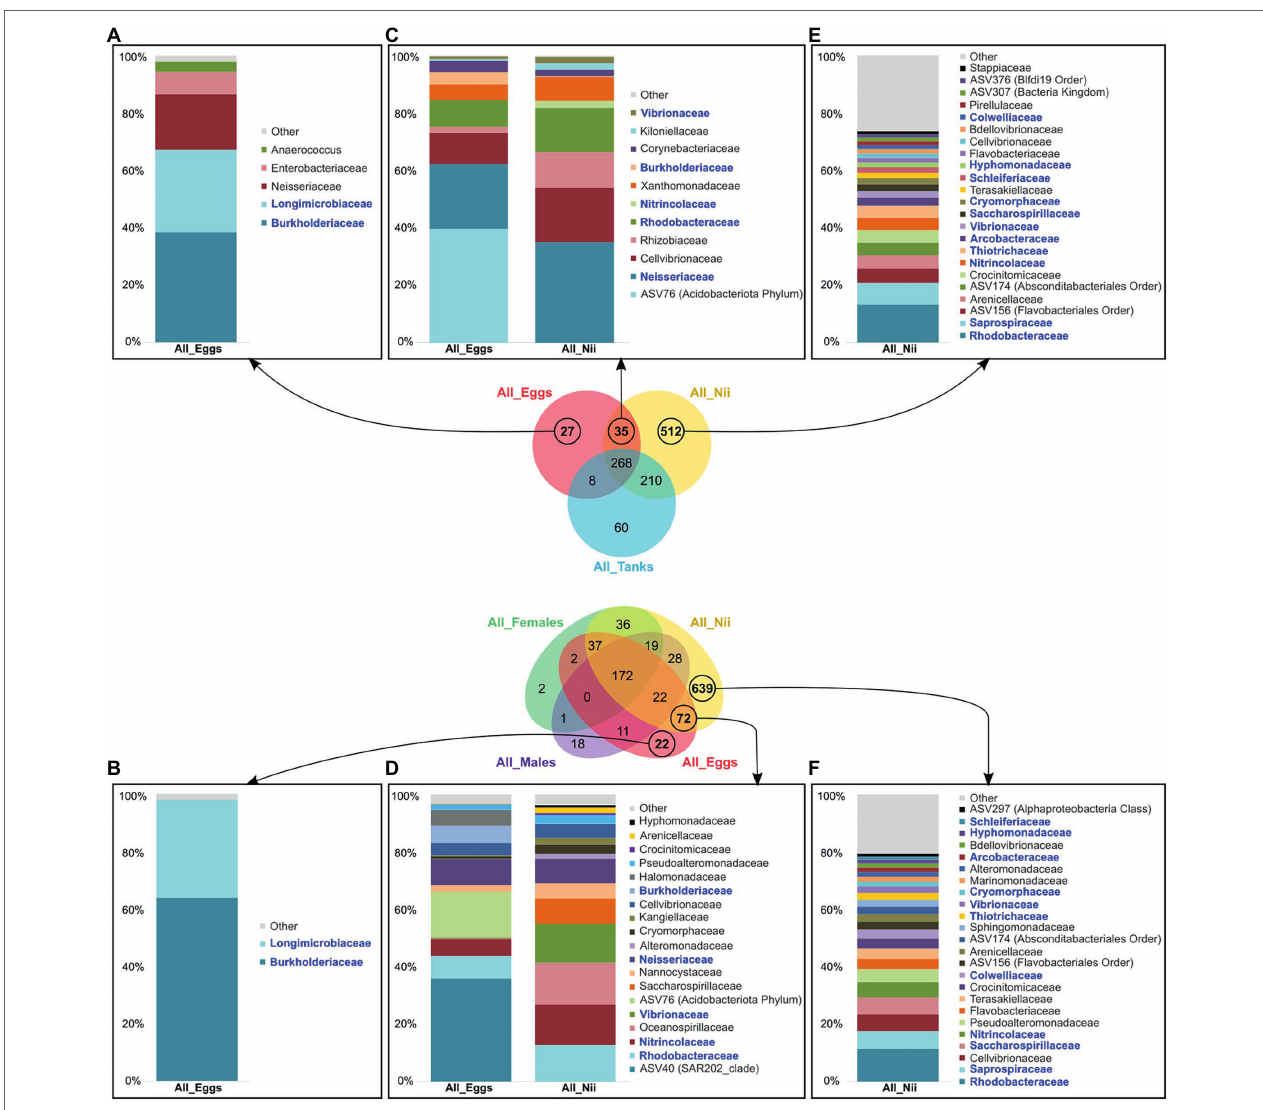
FIGURE 6 | Specific and shared bacterial lineages among the eggs and the nauplii. Top bacterial families with a total relative abundance higher than 1% (A) specifically found in the eggs in Venn1 (27 ASVs) and (B) in Venn2 (22 ASVs), (C) shared between the egg and the nauplius (nii) samples in Venn1 (35 ASVs) and (D) in Venn 2 (72 ASVs), (E) specifically associated with the nauplii (nii) in Venn1 (512 ASVs), and (F) in Venn2 (639 ASVs). The bacterial families in blue are the bacterial families shared between histograms which were constructed by averaging the triplicates for each sample